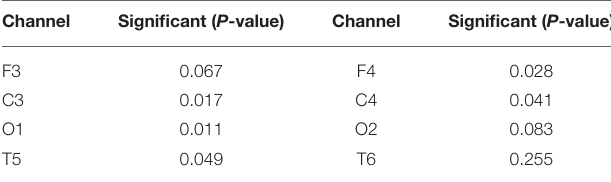
TABLE 1 | Significance test results of WMMSE pre- and post-NFT. Channel Significant ( P -value)